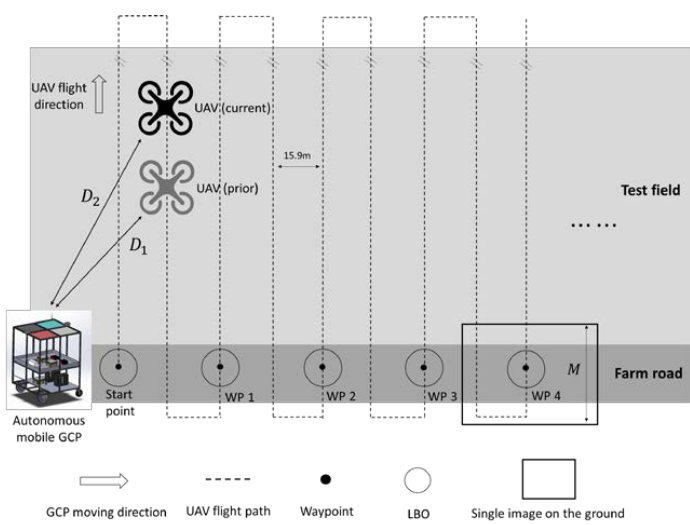
Figure 5. Collaboration strategy between the UAV and the autonomous mobile GCP on a farm field.